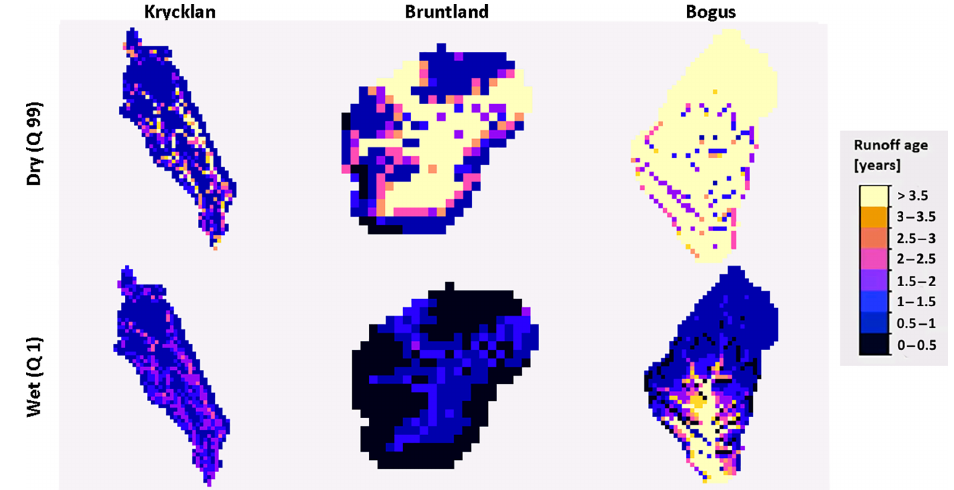
Figure 9. Spatial distribution of water age in each catchment for dry (1% quantile) and wet (99% quantile) conditions. Model outputs are extracted from a single model run with the “best” model fit in each site.